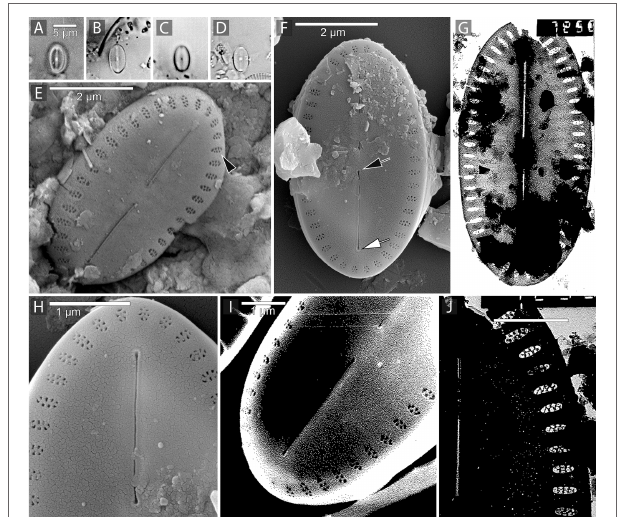
FIGURE 1 | Amicula specululum (Witkowski) Witkowski, Lange-Bertalot & Metzeltin the generitype of the genus. Figures (A–D) . Light microscopic images of Amicula specululum from the type habitat in Puck Bay, Southern Baltic Sea. Figures (E, F, H, I) . SEM images illustrating the valve exterior. Figures (G, J) . TEM images from Puck Bay. Figures (F, H) . specimens from the Western Baltic Sea. Figure (E) . Specimen with well-developed cribrate areolae (black arrowhead). Note the short raphe branches and relatively large central nodule. Figures (F, H) . Valve exterior with central raphe ending (black arrow) and apical raphe ending (white arrow). Figures (G, J) . Cribrate areolae and short raphe branches illustrated in